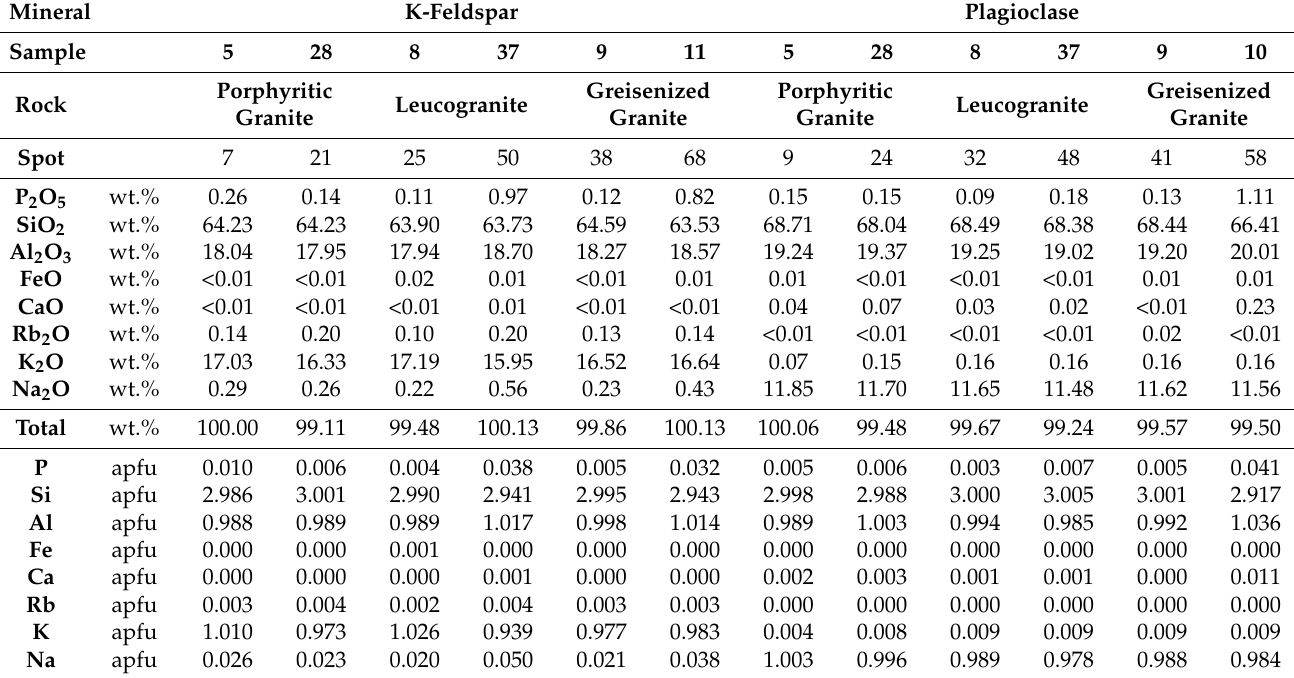
Table 5. Chemical composition (wt.%, EMPA) and empirical formulae of